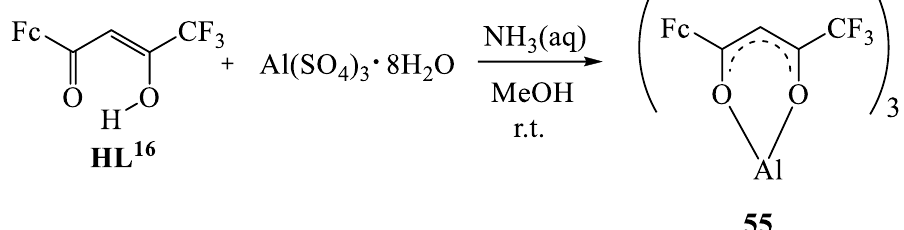
Figure 28. Molecular structure of 54 [97]. Hydrogen atoms have been omitted, C 2 F 5 groups are trans- parent for clarity. The cif has been retrieved from CCDC. CCDC number is 984498.